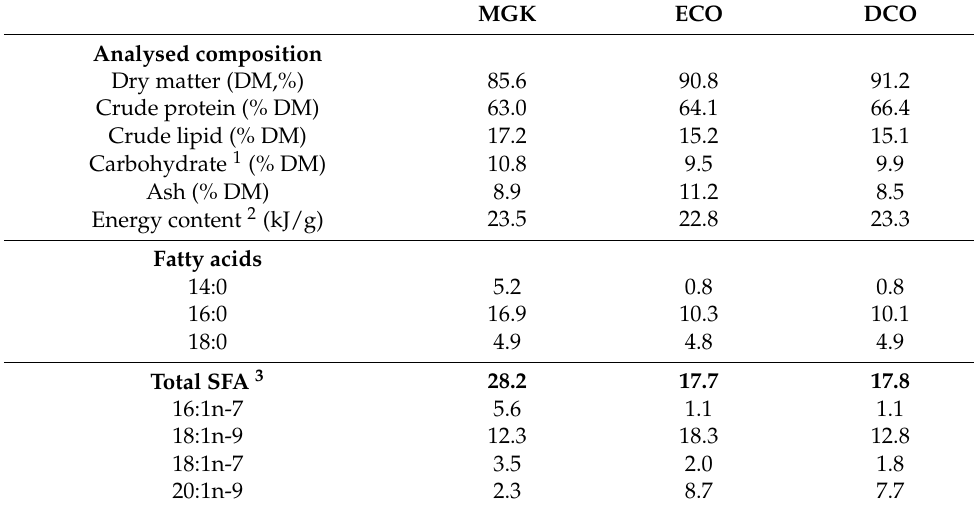
Table 2. Analysed proximate compositions (% dry mass), estimated energy contents and fatty acid profiles (% of total fatty acids) of the reference (MGK) and test (ECO and DCO) diets. MGK ECO DCO Analysed composition Dry matter (DM,%) Crude protein (% DM) Crude lipid (% DM) Carbohydrate 1 (%